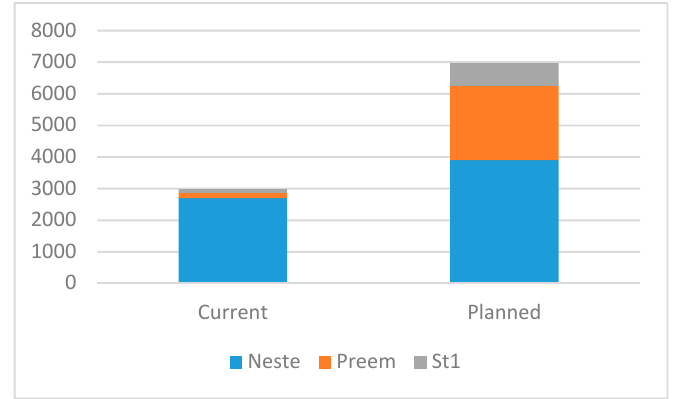
Figure 11. Petroleum industry projects: Source: [8–10,30,32].